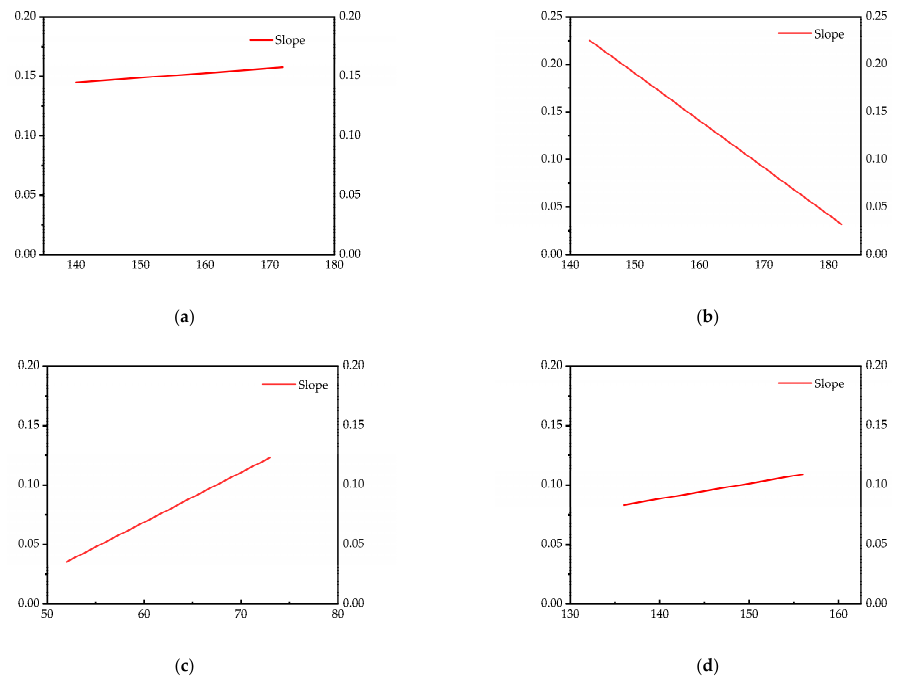
Figure 5. The change in the slope of the feature possibility distribution function: ( a ) HD ( b ) IN ( c ) FE ( d ) NDVI. We analysed the change in curvature of different probability assignment functions; the slope value of HD and NDVI change very little when the grey scale value changes, which can be approximated as constant. The slope of IN has been decreasing, indicating that the trend of the change in the probability distribution curve is becoming slower. This suggests that the BPA function for IN should be chosen as the fast-first, then slow type. The slope value of FE changes from large to small, the feature value changes quickly and then slowly with the land cover classes. In this article, the triangular probability assign- ment function was chosen for HD and NDVI. the ridge probability assignment function was chosen for IN, and the pointed probability assignment function was chosen for FE. Relying on the acquired raw feature data, after selecting the BPA function form and parameters, a better BPA function describing uncertainty can be obtained. Then the final BPA functions for the four features are shown in Figure 6. On the basis of the constructed BPA function, the DS evidence synthesis is used to discriminate the results of pixel point feature classification. While DS evidence synthesis is the fusion of BPA functions of different bodies of evidence under the same proposition, and the comparison of results by setting the corresponding decision criteria, ultimately achieving an accurate decision on the classification results.